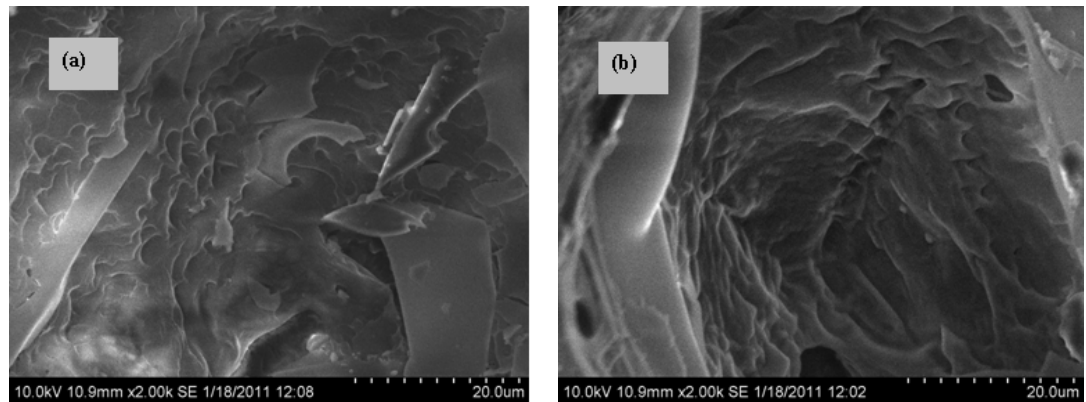
Figure 2. SEM images of the RT28/EP composite PCMs with 30 wt % ( a ) and 40 wt % ( b ) of RT28.